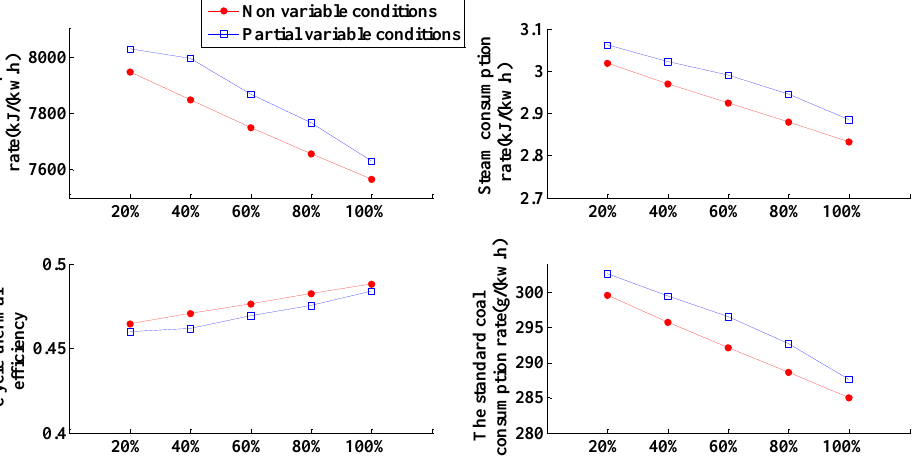
Figure 11. SAPG system 2nd thermal economy.